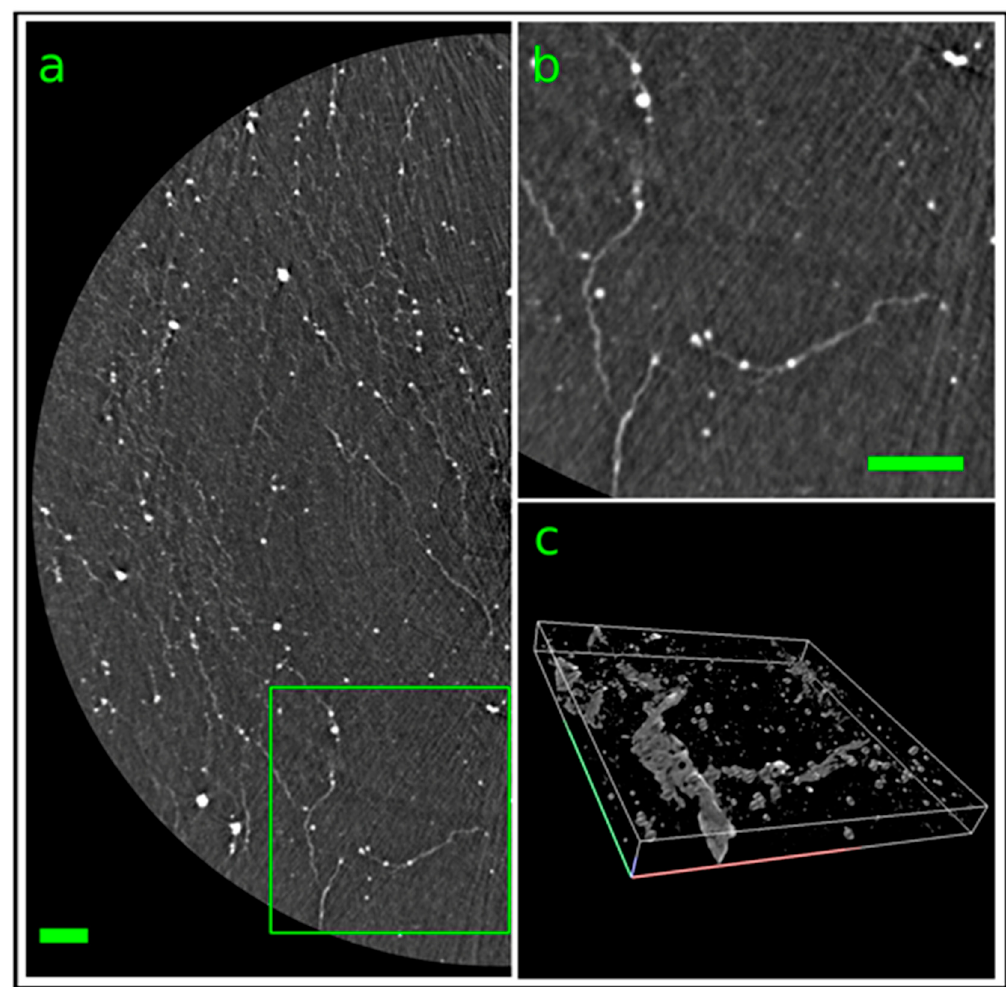
Figure 5. Synchrotron-based X-ray µCT analysis of one treated scaffold imaged at the SYRMEP beamline of Elettra. Panel (a) represents a reconstructed axial slice of the scaffold (isotropic voxel size = 0.9 µm) highlighting the presence of mineral depositions (white dots) along brighter filaments. Panel (b) shows a zoom of the green ROI indicated in panel (a). Panel (c) depicts a 3D rendering of 50 adjacent slices (400 × 400 × 50 µm 3 ) showing the 3D distribution of the mineral depositions. Scale bars = 100 µm.